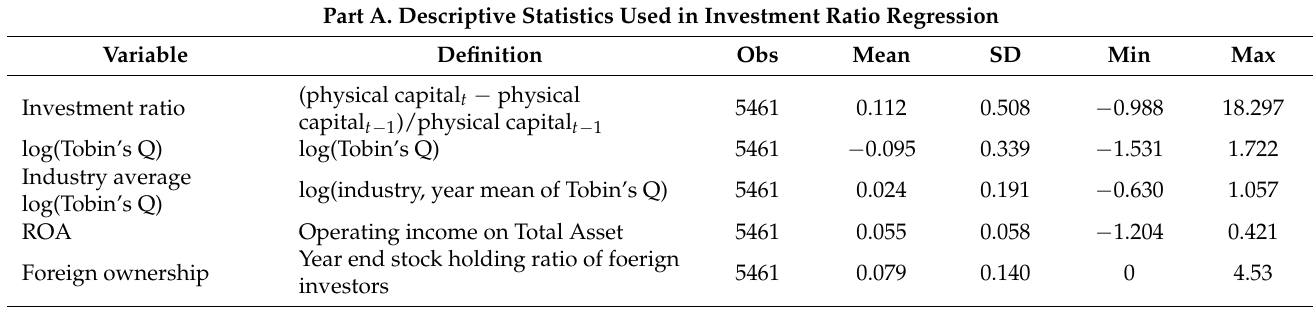
Table A2. Descriptive statistics of variables used in regressions comparing the US and Korean firms. Part A. Descriptive Statistics Used in Investment Ratio Regression